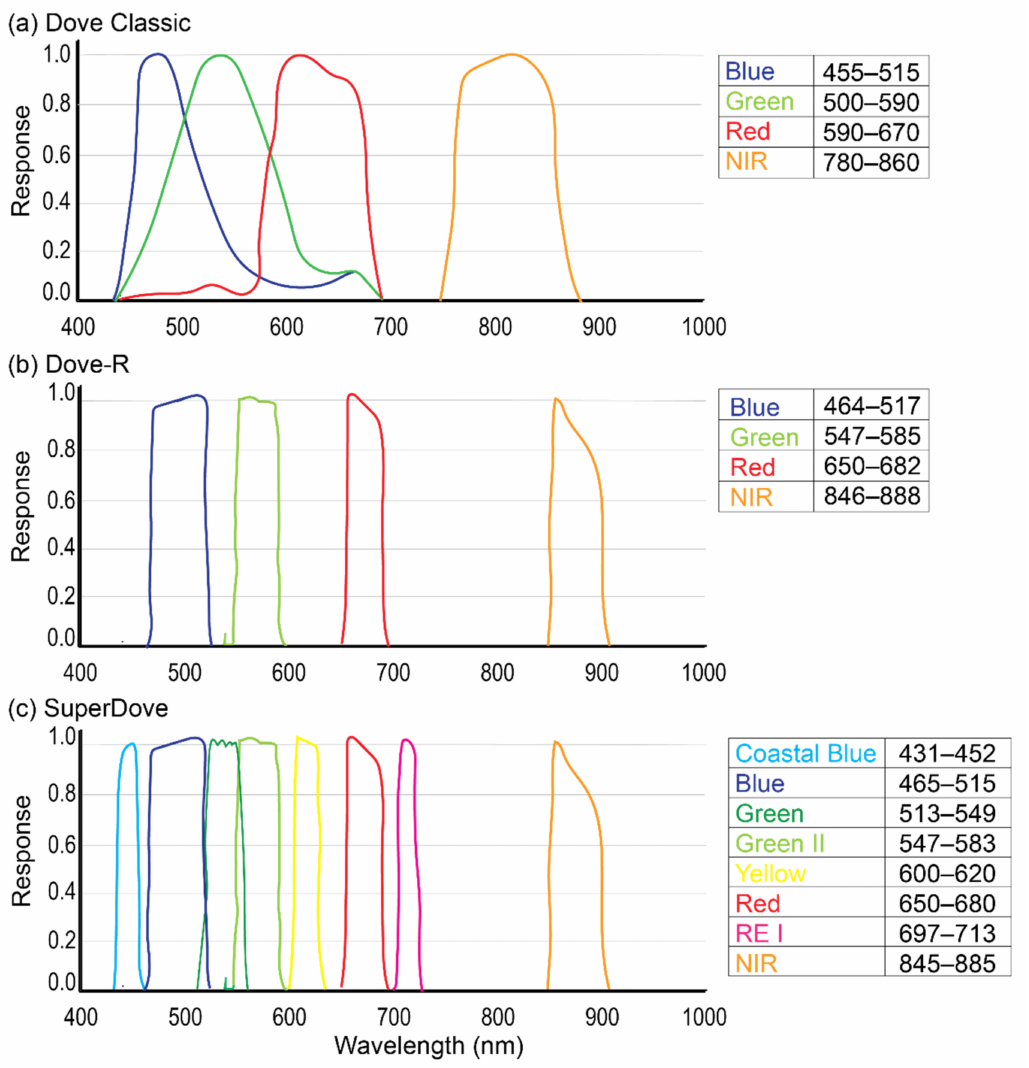
Figure 2. Spectral responses for PlanetScope: ( a ) Dove Classic ‘PS2’, ( b ) Dove-R ‘PS2.SD’, and ( c ) SuperDove ‘PSB.SD’ sensors. Adapted from